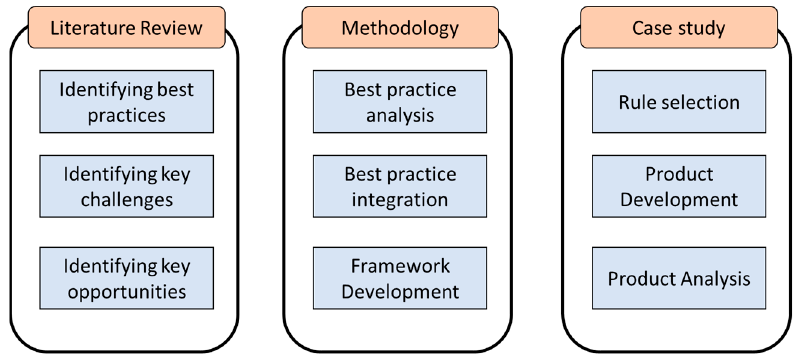
Figure 1. The overall methodology of the research.